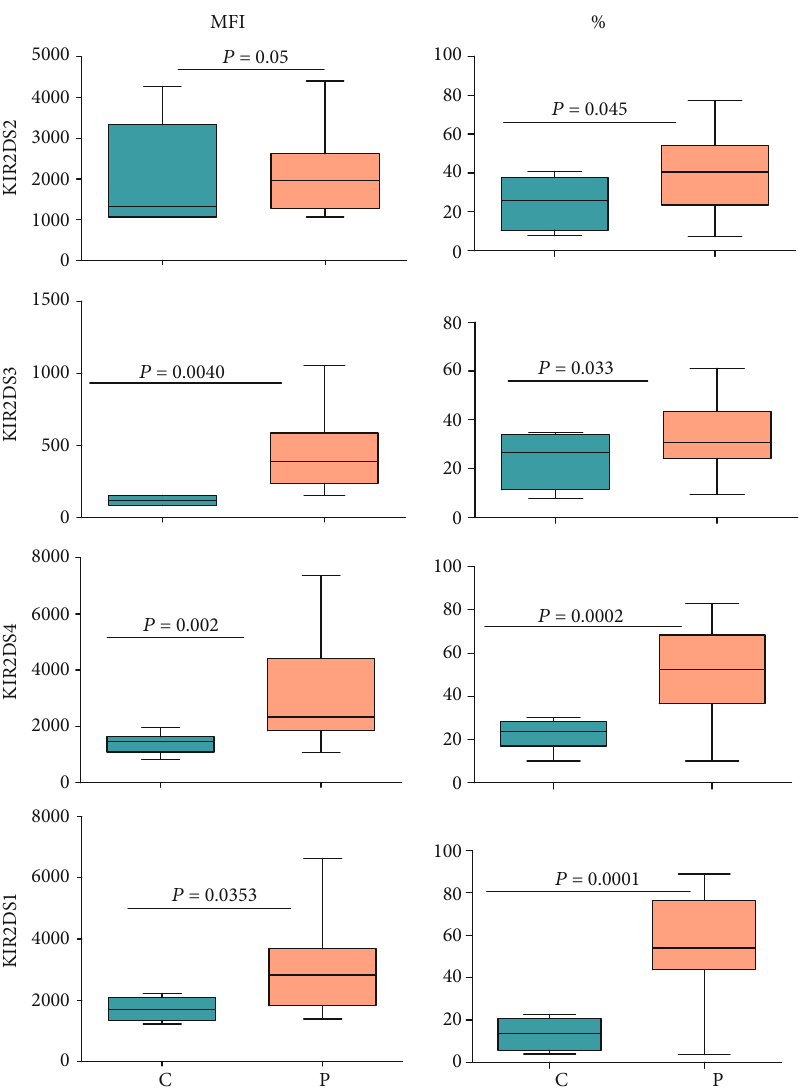
Figure 2: Expression of activating KIR on NK cells in CD patients and healthy controls. Fifty microliters of blood samples was used and stained for CD3, CD14, and CD19 and activating KIR (PE or FITC-conjugated) as described in Materials and Methods. The expression was determined on CD3-CD14-CD19-CD56 bright/dim (NK) cells. The fi gure shows mean fl uorescence intensities (MFIs) and percentages of NK cells expressing the receptor from 15 treatment-naïve patients and 20 healthy controls. Each box and whisker plot indicates median, upper and lower values, interquartile range, and p